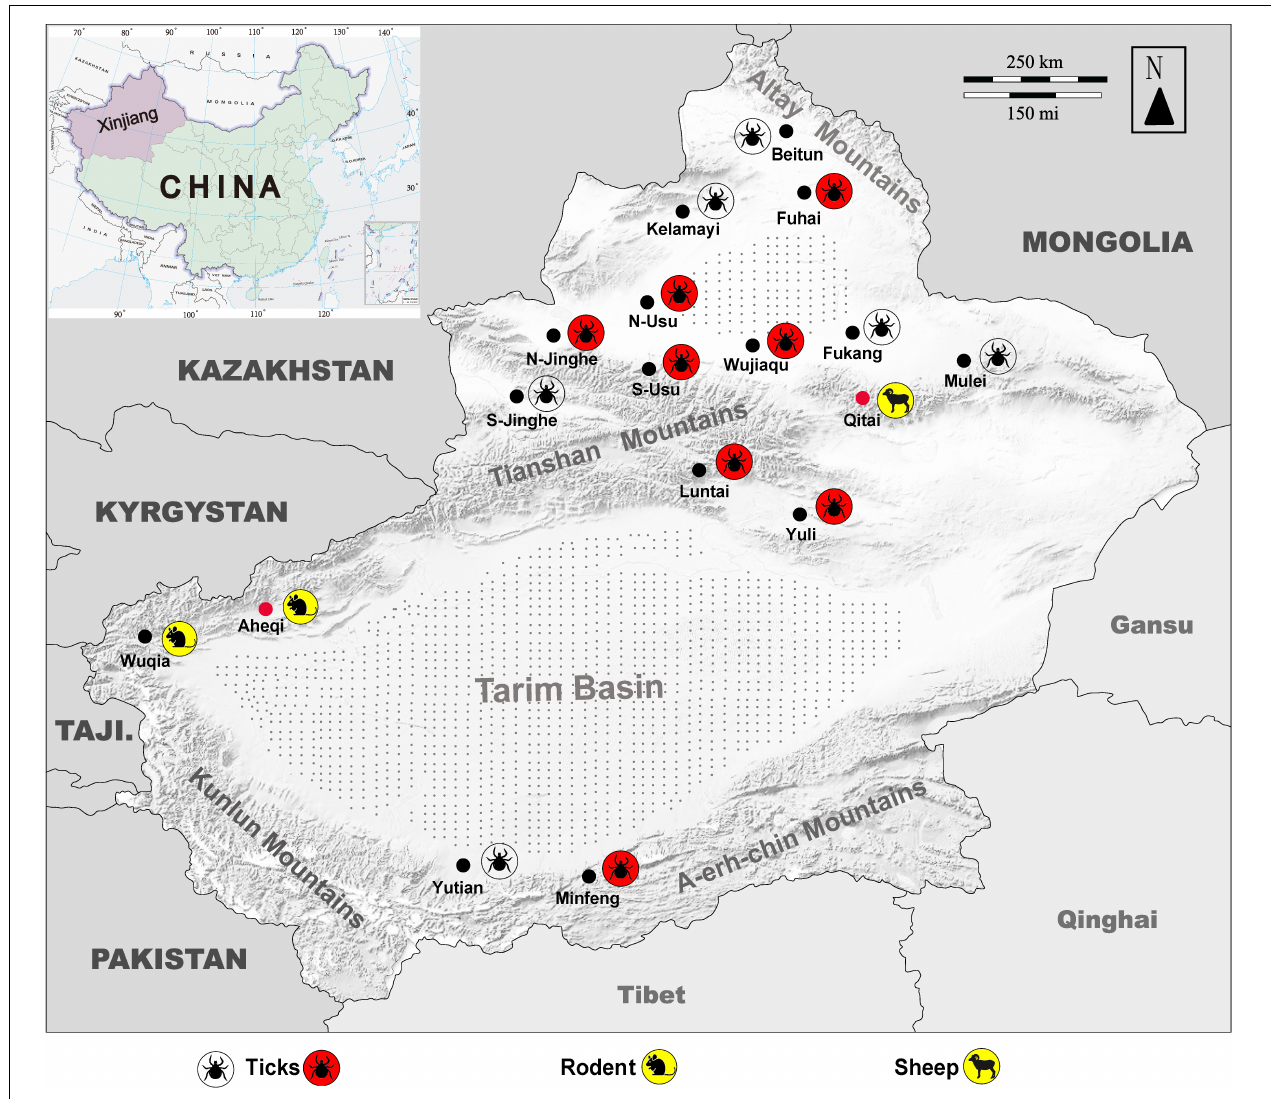
FIGURE 4 | Map of Xingjiang Region showing locations where KSIV infection was detected. Molecular, epidemiological, and serological investigations were conducted on ticks and field-collected animal sera from Xinjiang, revealing that the animals had serological exposure to tick-borne encephalitis virus (TBEV) as well as to KSIV. The map of Xinjiang, China, shows tick sampling locations and molecular epidemiology of KSIV, and anti-KSIV and anti-TBEV antibody detection in animal sera. The silhouette of a tick with a red background represents a sampling location where KSIV nucleic acid was detected, and the silhouette of a transparent tick represents a sampling location where KSIV was not detected. The silhouettes of sheep and rats on a yellow background represent the sampling locations (black dots) where KSIV-antibodies were detected, while the locations where the animal serum samples also had neutralizing antibodies to TBEV are indicated by red dots. Gray stippling indicates arid desert areas. S-Usu, South of Usu City; N-Usu, North of Usu City; S-Jinghe, South area of Jinghe County; N-Jinghe, North of Jinghe